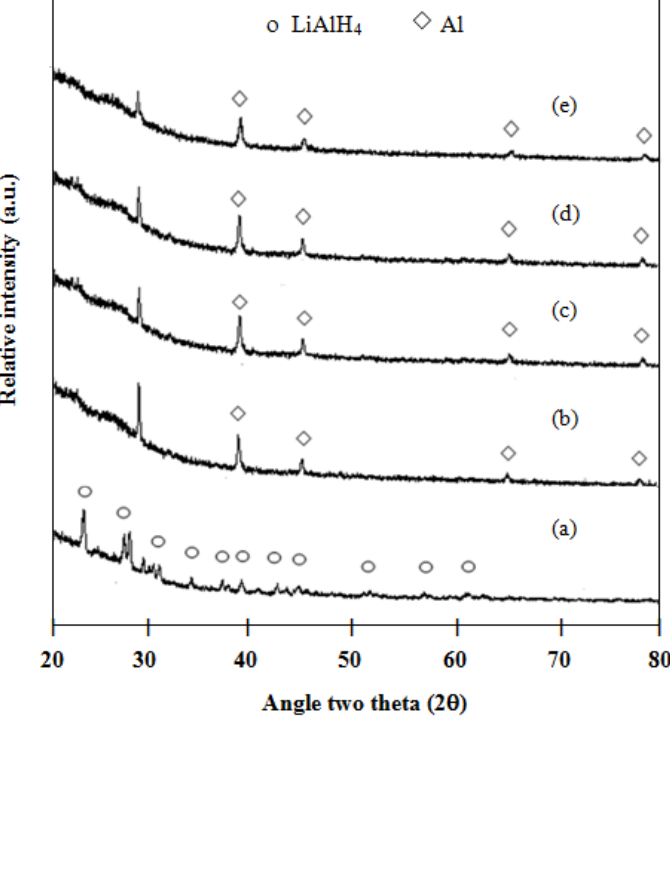
+LiBH ; 4 4 –2LiAlH +LiBH ; ( d ) 1 mol % 3 4 4 +LiBH 4 4